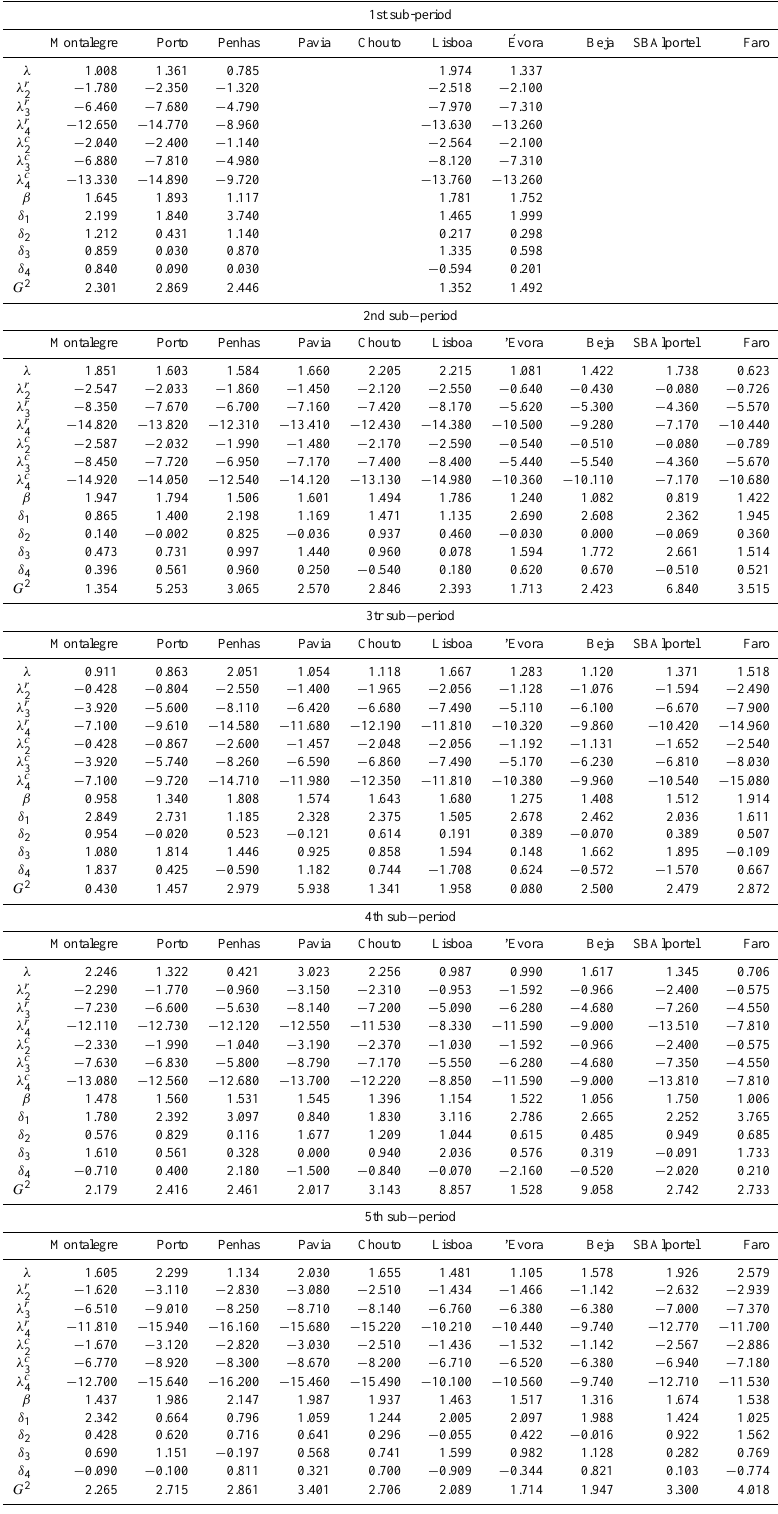
Table A1 Estimates of QA log-linear model parameters fitted to contingency tables and correspondent residual deviances for the 10 sites by